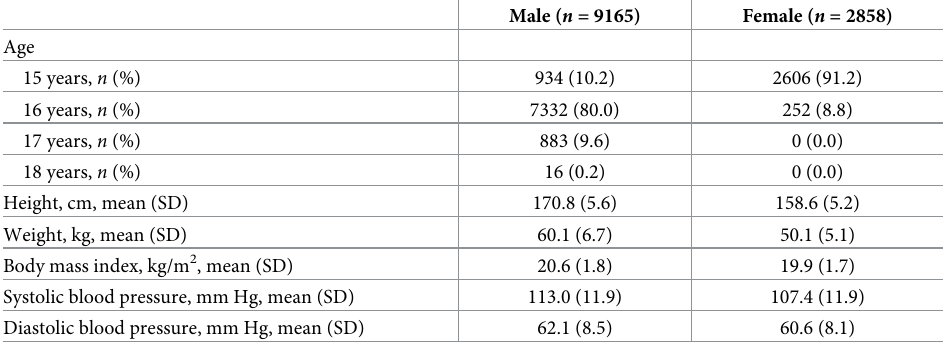
Table 1. Characteristics of the study